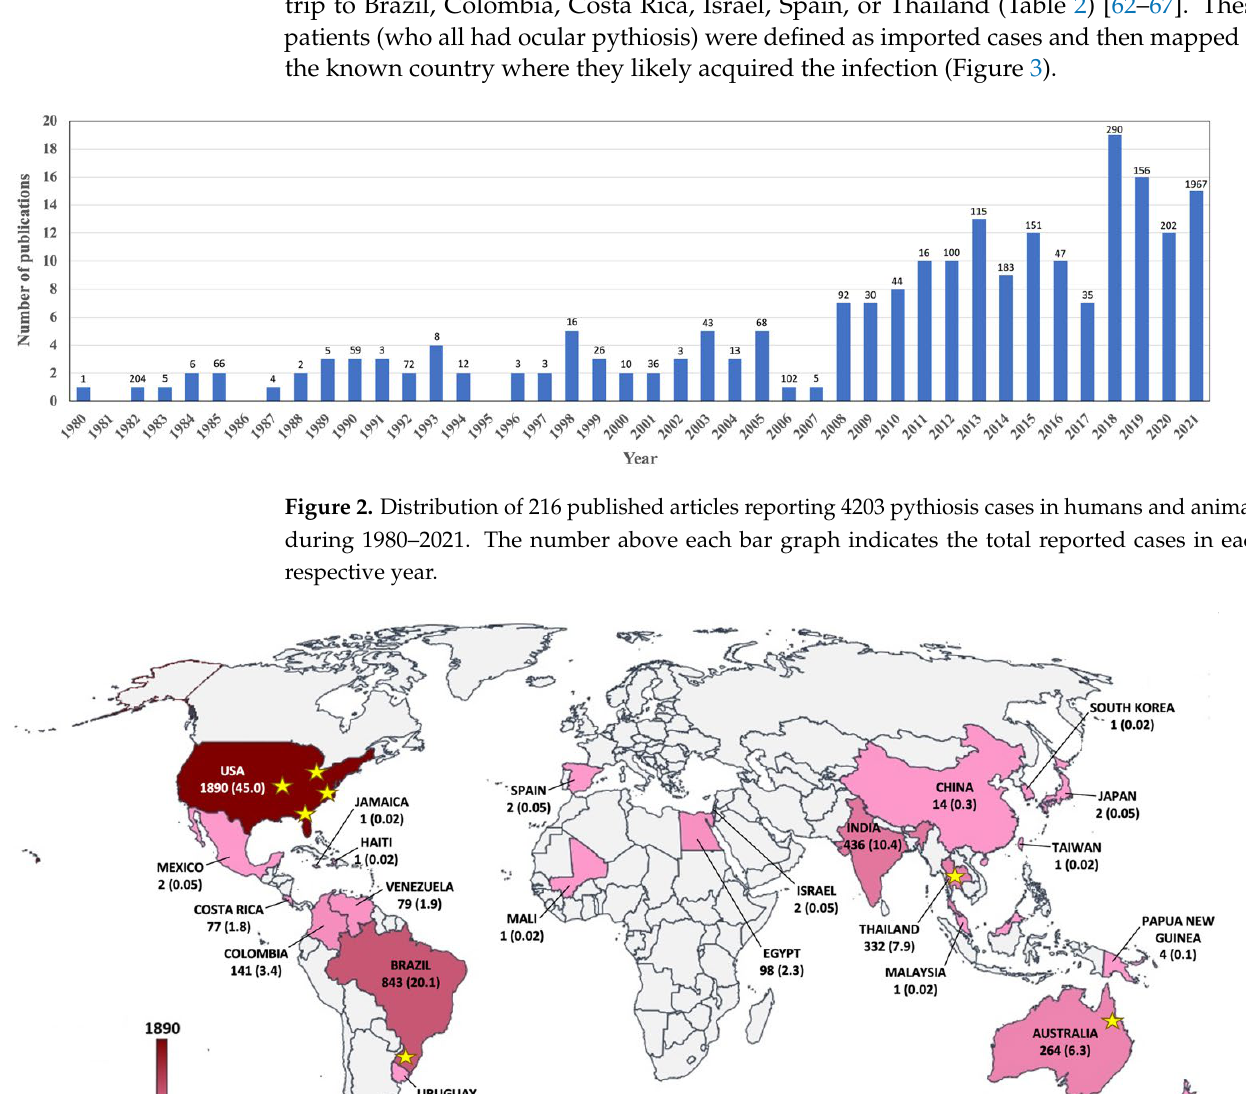
Figure 3. The world map shows the geographic distribution of pythiosis in humans and animals. The case numbers and percentages (in the parenthesis) are added to the countries where the patients acquired pythiosis. The color scale represents case density (ranging from 1 to 1890 cases). Stars indicate the areas or countries where P. insidiosum has been successfully isolated from the environment.